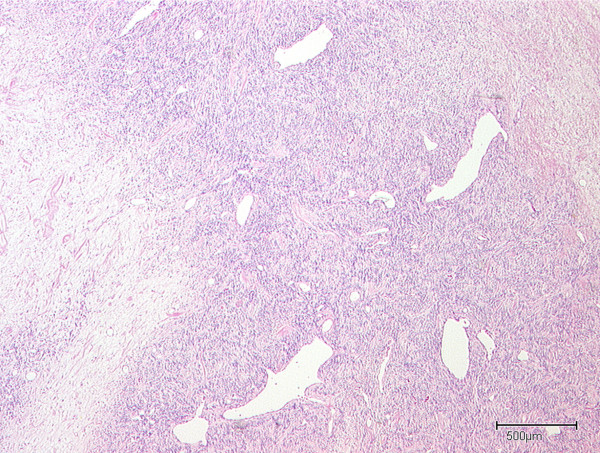
Microscopic aspect of SFT (a). Microscopic aspect of a solitary fibrous tumor: "Patternless" growth pattern with cellular (right half) and some myxoid (left half) areas, hemangiopericytoma-like wide blood vessels.